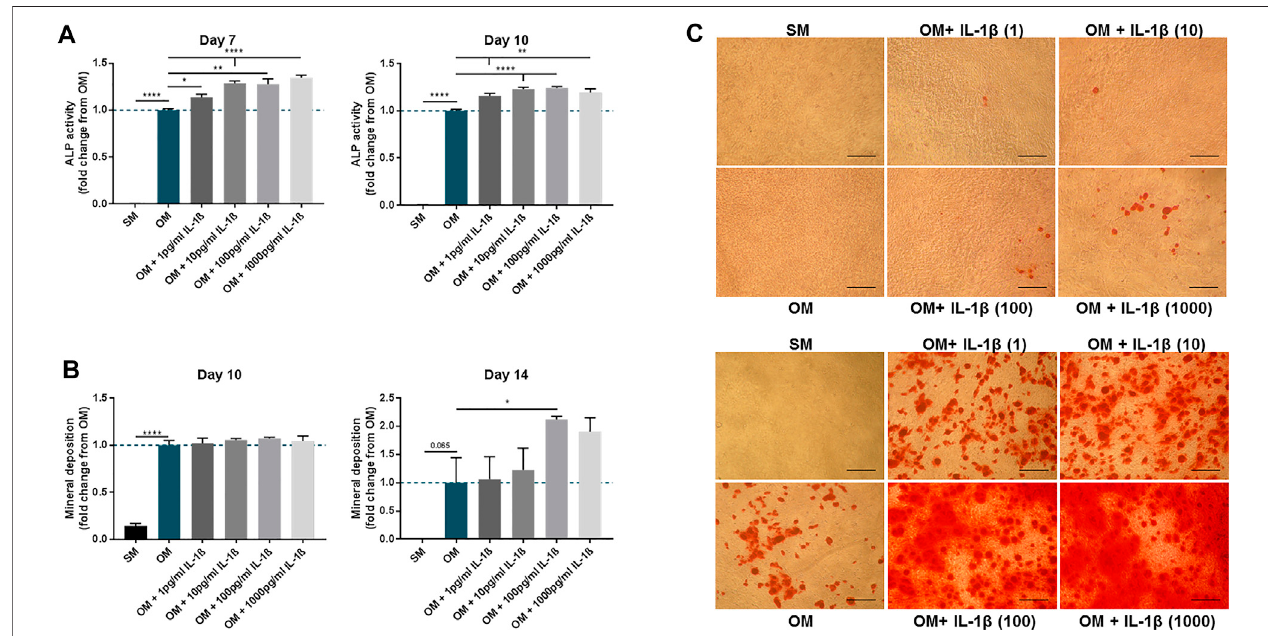
FIGURE 5 | Dose-response of IL-1 β (1 – 1,000 pg/ml) on MSC cultures undergoing osteogenic treatment. (A) ALP activity measured at day 7 and 10. (B) Mineral depositionmeasuredatday10and14. (C) RepresentativeimagesofAlizarinRedstainingatday10(upperpanel)and14(lowerpanel).Scalebar=150 μ m.Datashown as fold change compared to the OM control condition. Error bars represent SEM. n = 4, * p < 0.05, ** p < 0.01, *** p < 0.001, **** p <